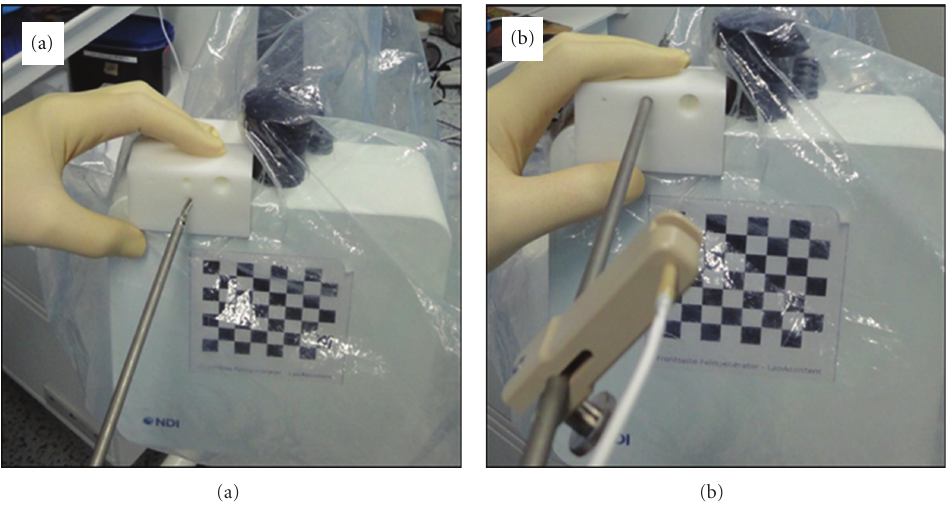
Figure 3: System calibration under sterile conditions. (a) Pivot shift calibration, (b) rotating